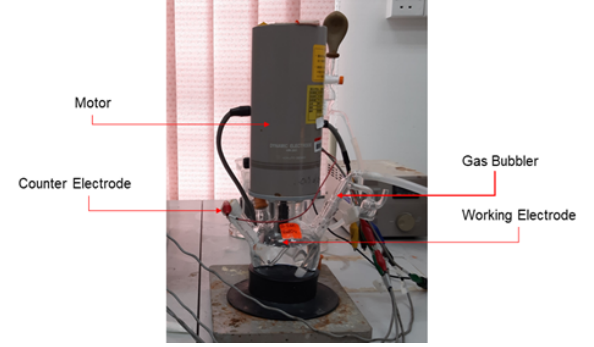
Fig. 2. Rotating Disk Electrode (RDE) setup.